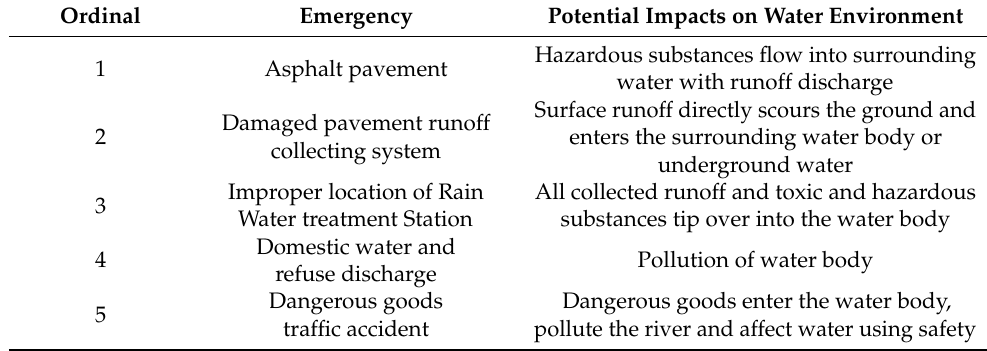
Table 5. Risk source identification